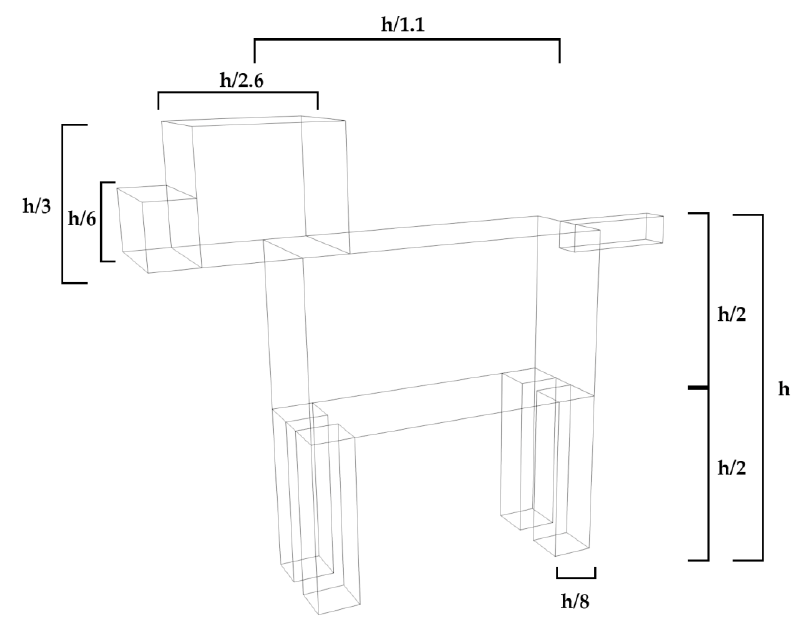
Figure 2. Proportions of simplified dog model according with chosen height for medium size dog.